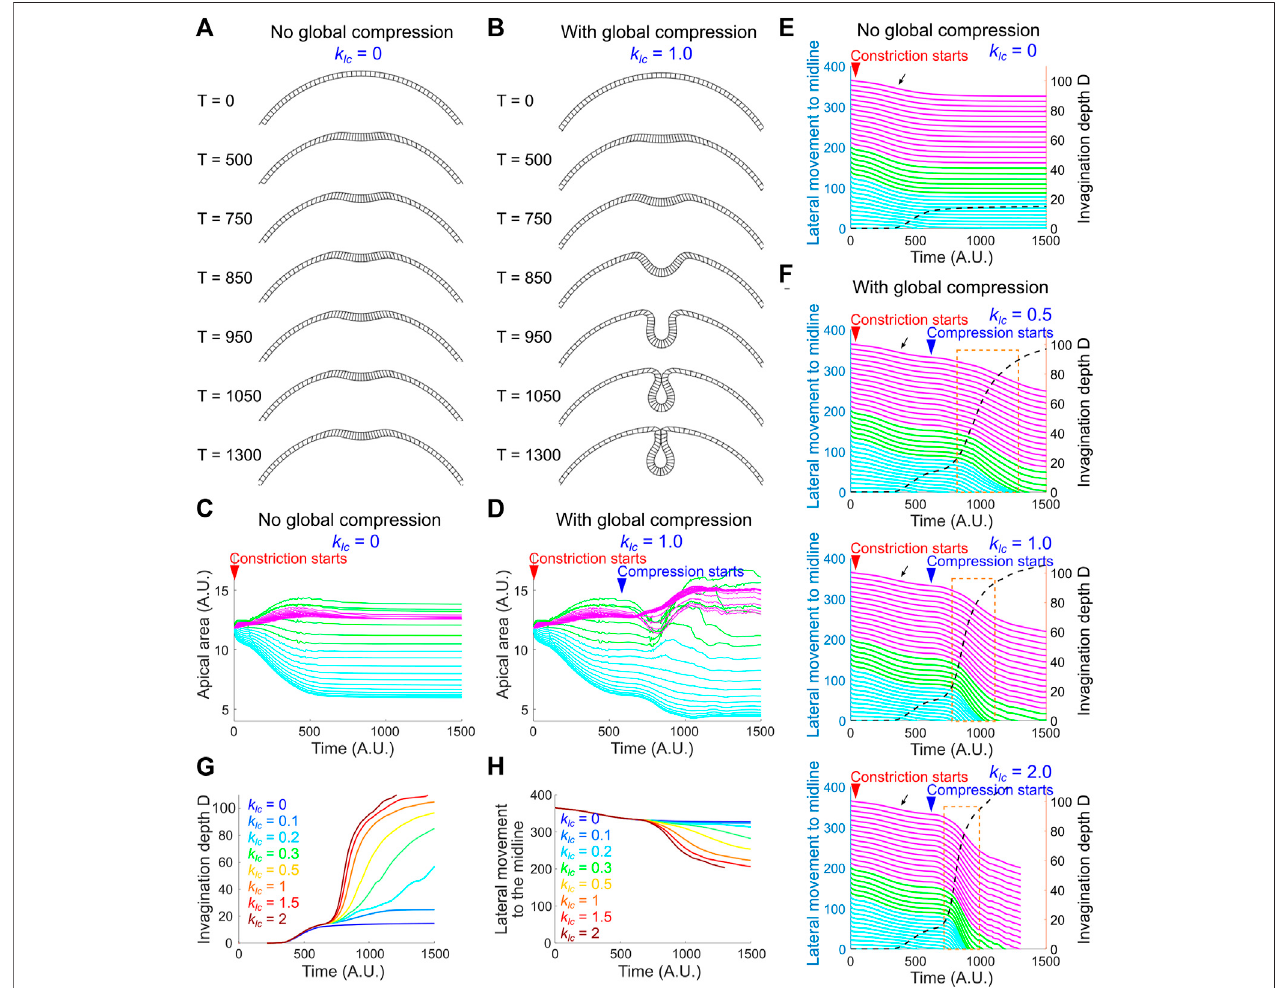
FIGURE 8 | A joint action of local apical constriction and global compression recapitulates real tissue dynamics during ventral furrow formation. (A , B) Simulated morphological change over time induced by apical constriction with or without global compression. k ac = 2.1 and k eg = 0.3 for all simulations shown in this fi gure. (C , D) Apical area change with or without global compression. The solid lines in (C – F) are color coded according to the color regime shown in Figure 7A . (E , F) Relationship between invagination depth D (dashed line) and the movement of the lateral non-constricting region ( “ lateral movement, ” solid lines) towards the midline in the presence or absence of compressive stresses. Orange box highlights the tight coupling between invagination and the lateral movement during the buckling transition. Black arrow indicates a slight lateral movement during the apical constriction phase which is not observed in real embryos ( Figure 6D ). Larger k lc (stronger global compression) results in faster invagination and lateral movement during the buckling transition (orangeboxes). (G , H) Simulated invagination depth D and the movement of a laterally localized unit towards the midline under different k lc